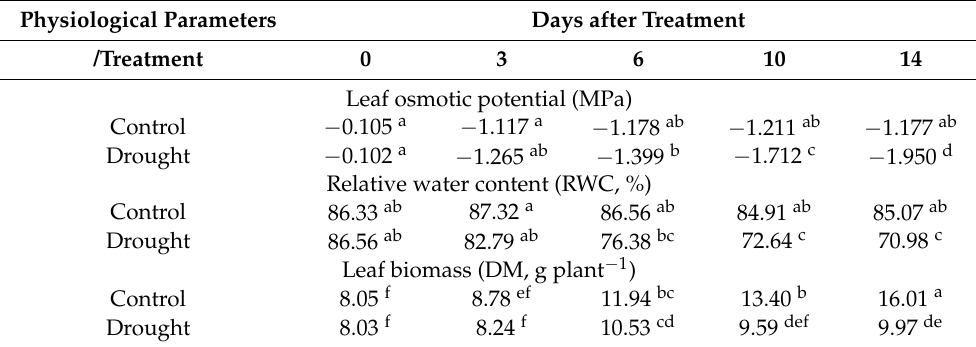
Table 1. Changes in the leaf osmotic potential, relative water content, soil water content, leaf biomass, and leaf total carbon concentration in the leaves of well-watered (control) or drought-stressed plants for 14 days. Physiological Parameters Days after Treatment /Treatment